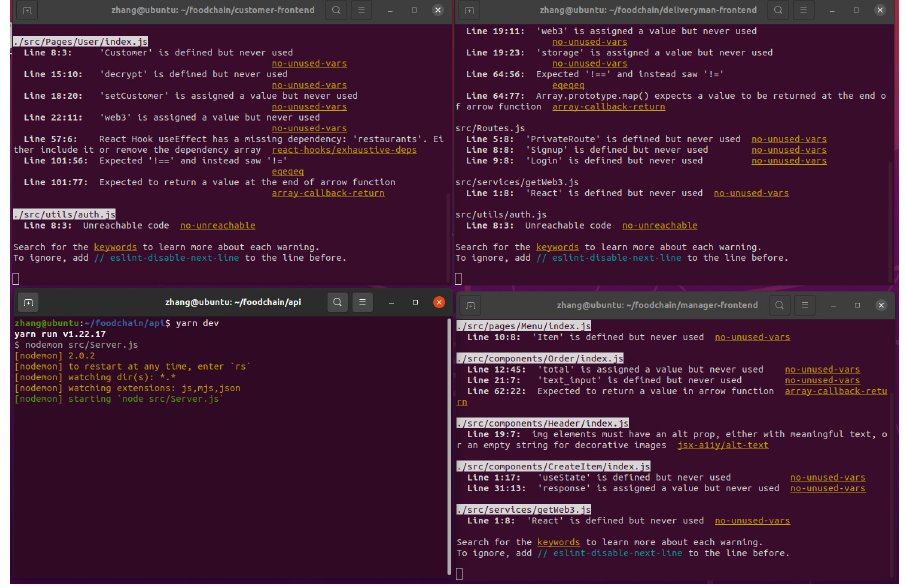
Figure 38. Start the server and client systems.